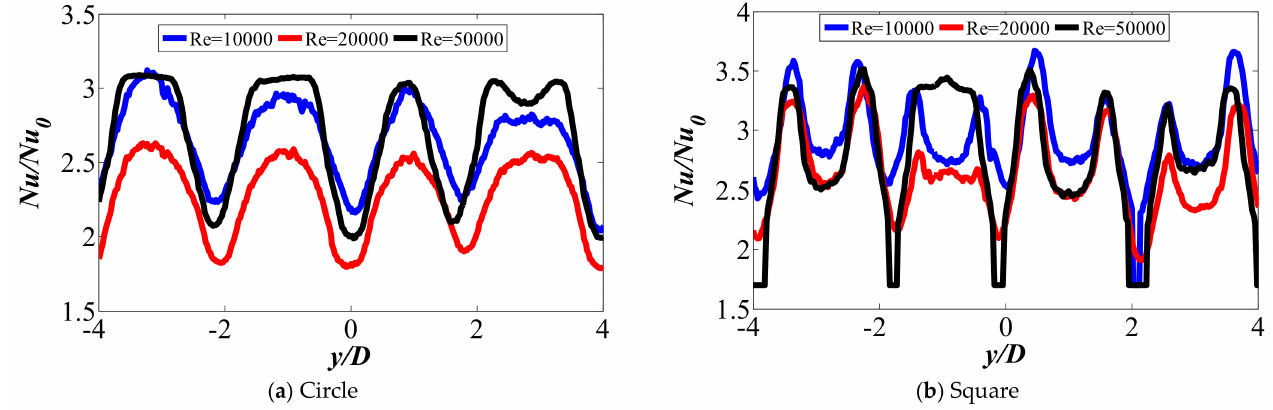
Figure 11. Spanwise heat transfer enhancement of Circle and Square pin fin at x / D = 1.